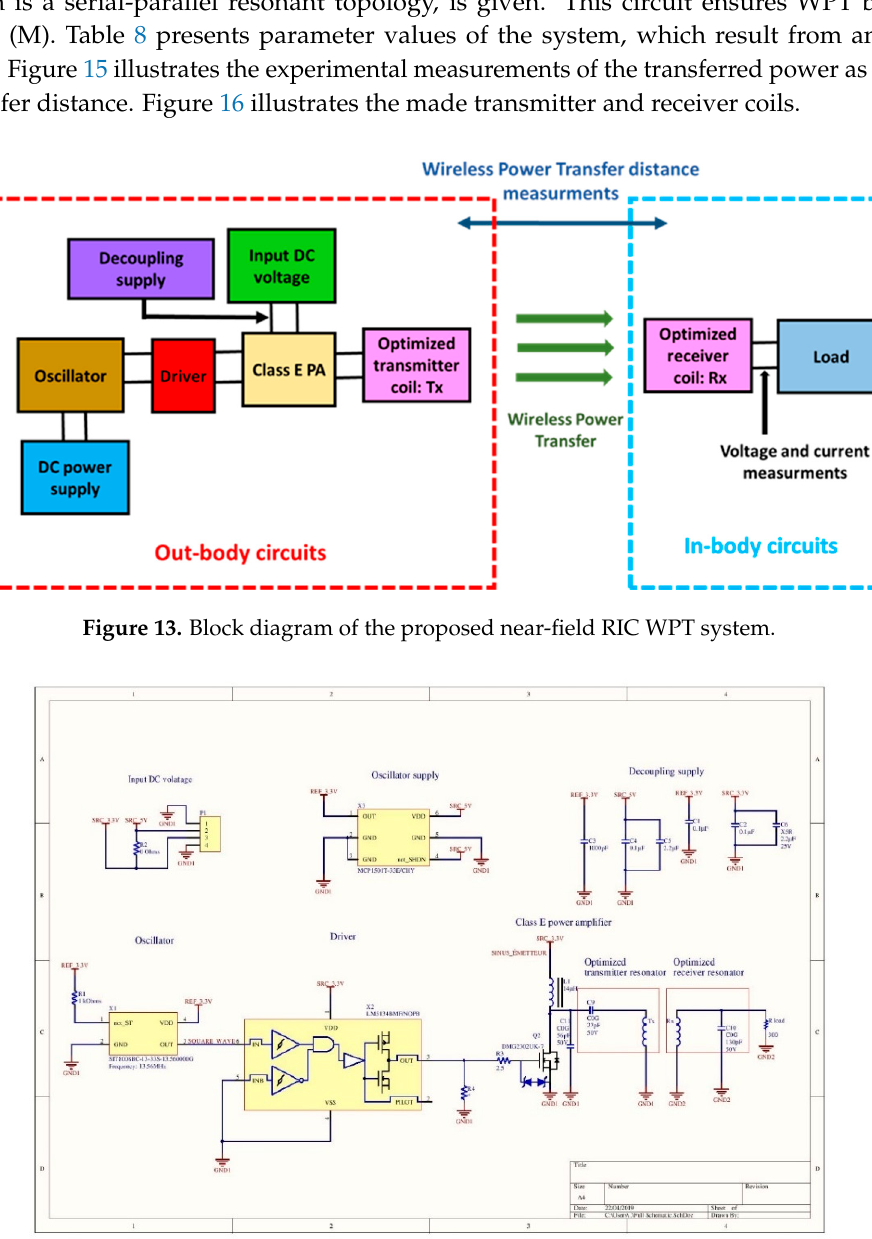
(ns) Figure 15. Experimental setup to measure the transferred power as a function of the transfer distance.